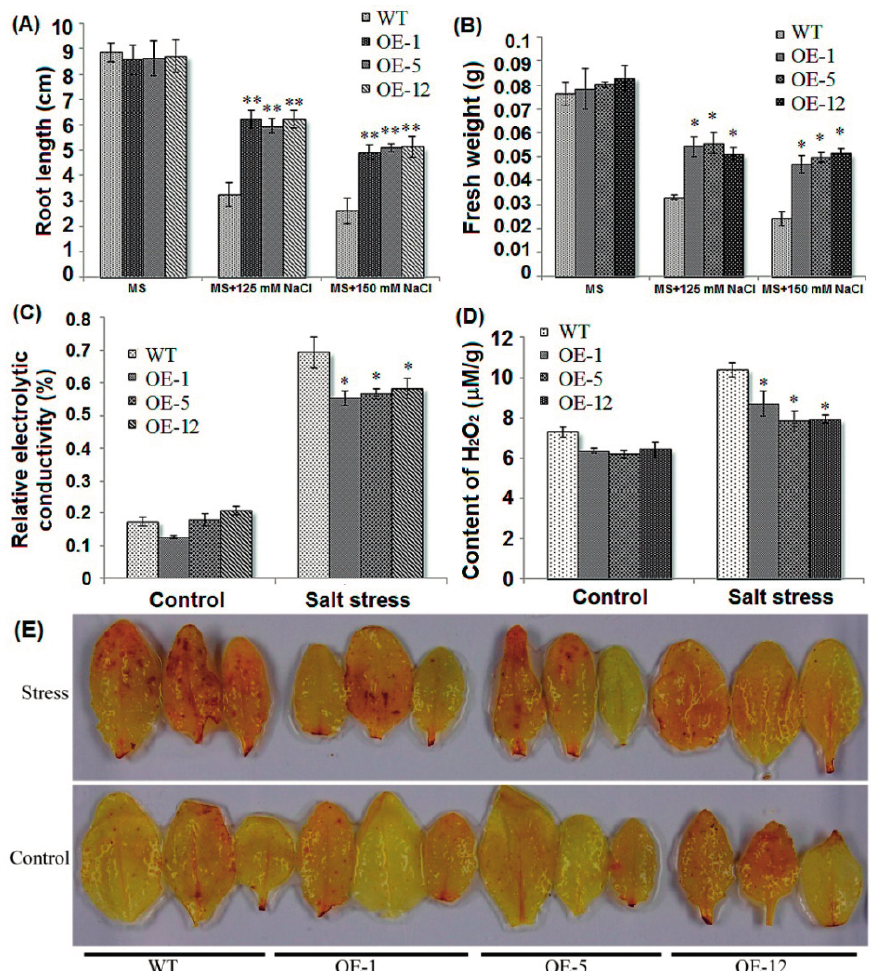
Figure 2. Physiological measurement of ZmCIPK21 -over-expressing transgenic plants. ( A ) Root elongation of wild-type (Col-0) and ZmCIPk21 -OE seedlings grown on MS agar plates containing different concentrations of NaCl (0, 125, or 150 mM) for 16 days; ( B ) Fresh weights of wild-type (Col-0) and ZmCIPK21 -OE seedlings grown on MS agar plates containing different concentrations of NaCl (0, 125, or 150 mM) for 16 days; ( C ) Relative electric conductivity of leaves from ZmCIPK21 OE and wild-type seedlings after salt stress (125 mM NaCl); ( D ) H O accumulation in wild type and transgenic plants under control 2 2 or salt stress (150 mM NaCl) conditions; ( E ) Diaminobenzidine (DAB) staining of true leaves of wild-type and transgenic plants under control or salt stress (150 mM NaCl)